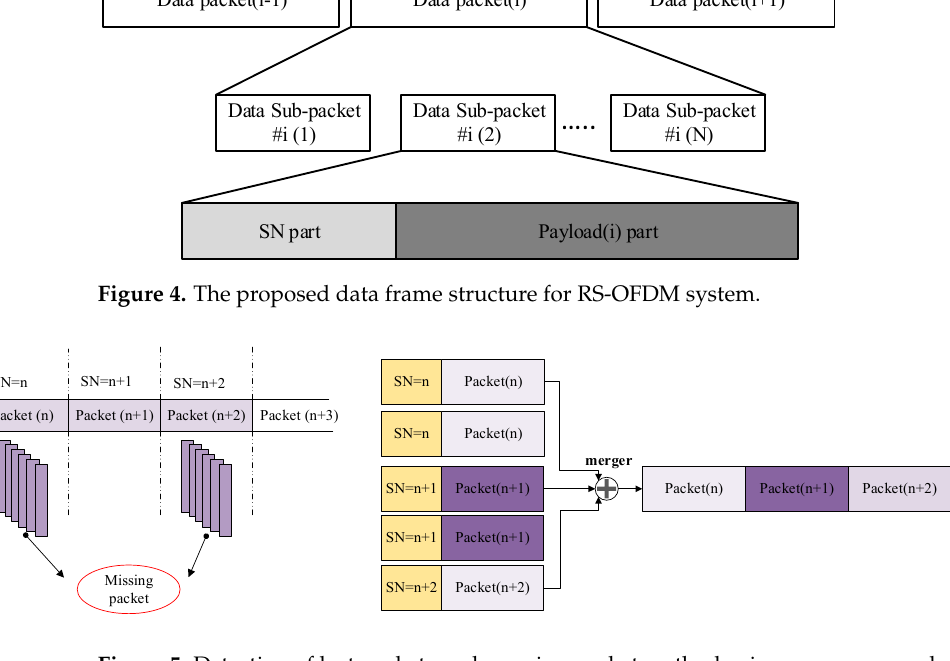
Figure 3. Deep learning for the starting point of OFDM frame .